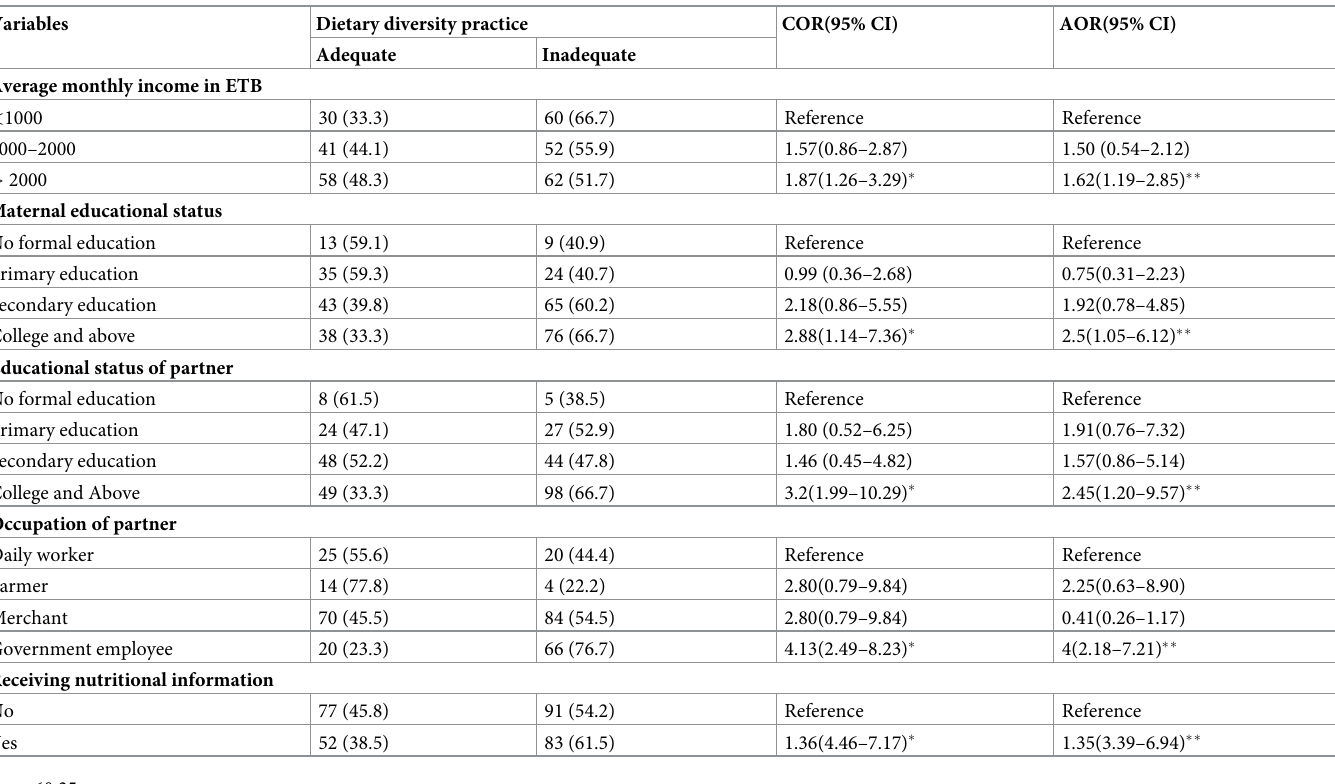
Table 4. Determinants of dietary diversity practice among study participants in Wachemo University Nigist Eleni Mohammed Memorial referral hospital,